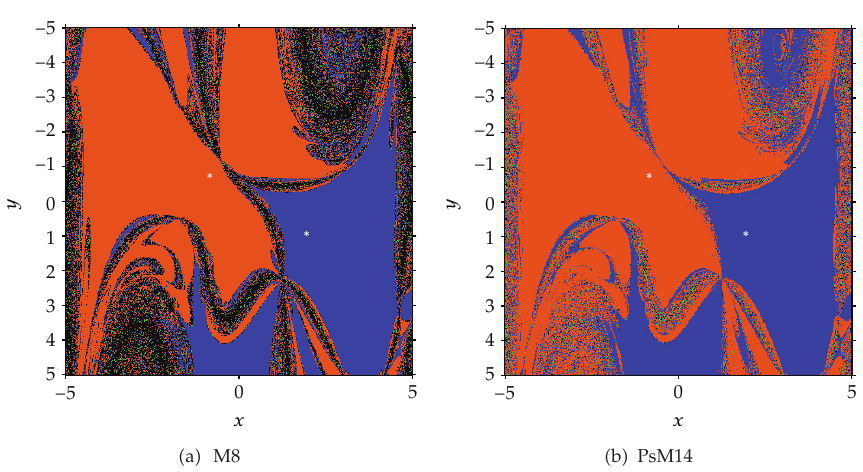
Figure 3: Real dynamical planes for system F 2 (cid:4) x (cid:5) (cid:6) 0 and methods M8 and PsM14.